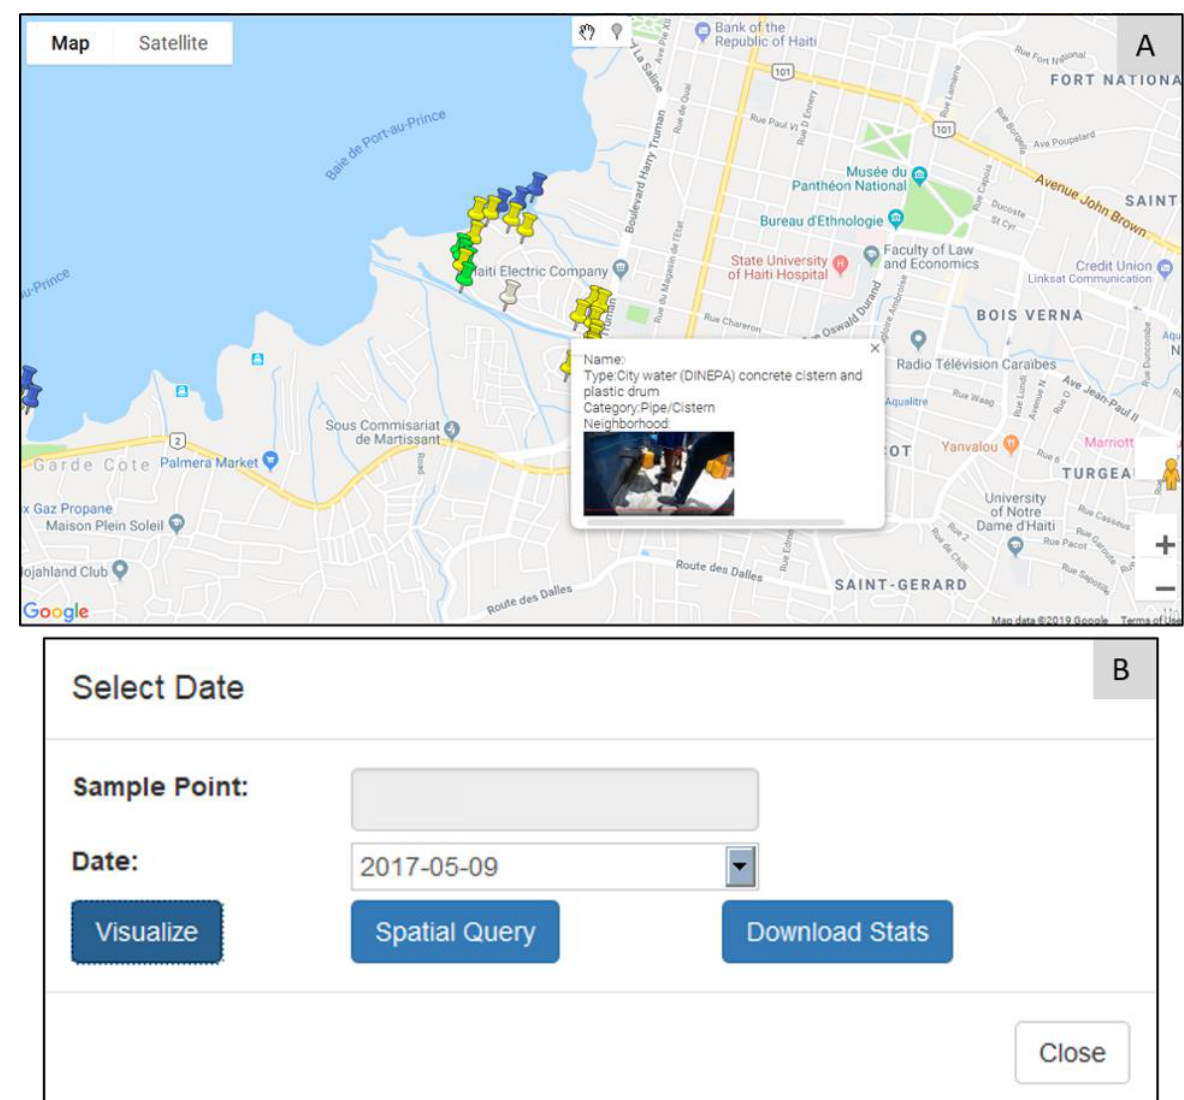
Figure 3. Water point visualization and parameter selection. ( A ) Water points represented as marker pins; ( B ) Clicking on a marker displays the visual parameters. The yellow, green, blue, and white markers indicate pipe, drainage, ocean, and combined water point types, respectively.